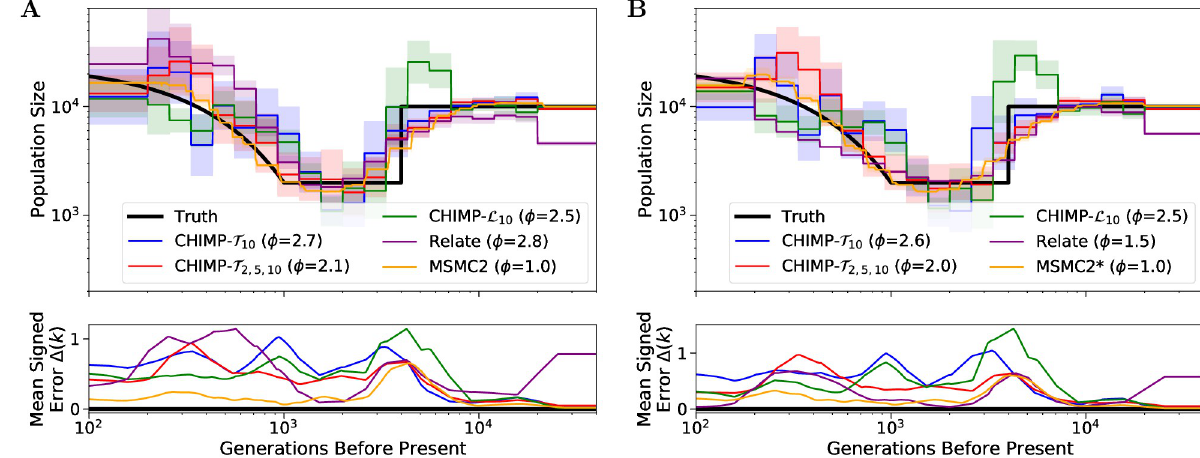
Fig 9. Results of inference in the bottleneck followed by growth scenario for sample size 10 (Panel A) and 200 (Panel B). We compare the inference of CHIMP , MSMC2 , and Relate using a piecewise constant population size history with 19 change points. Truth shown in black. Solid lines are averages over 16 replicates and shaded areas indicate standard deviation. Mean signed error Δ ( k ) is shown in bottom plot and has been smoothed using moving average for visualization purposes, The integral ϕ is indicated in the legend. ( � ) For sample size 200, MSMC2 was run on 50 non- overlapping